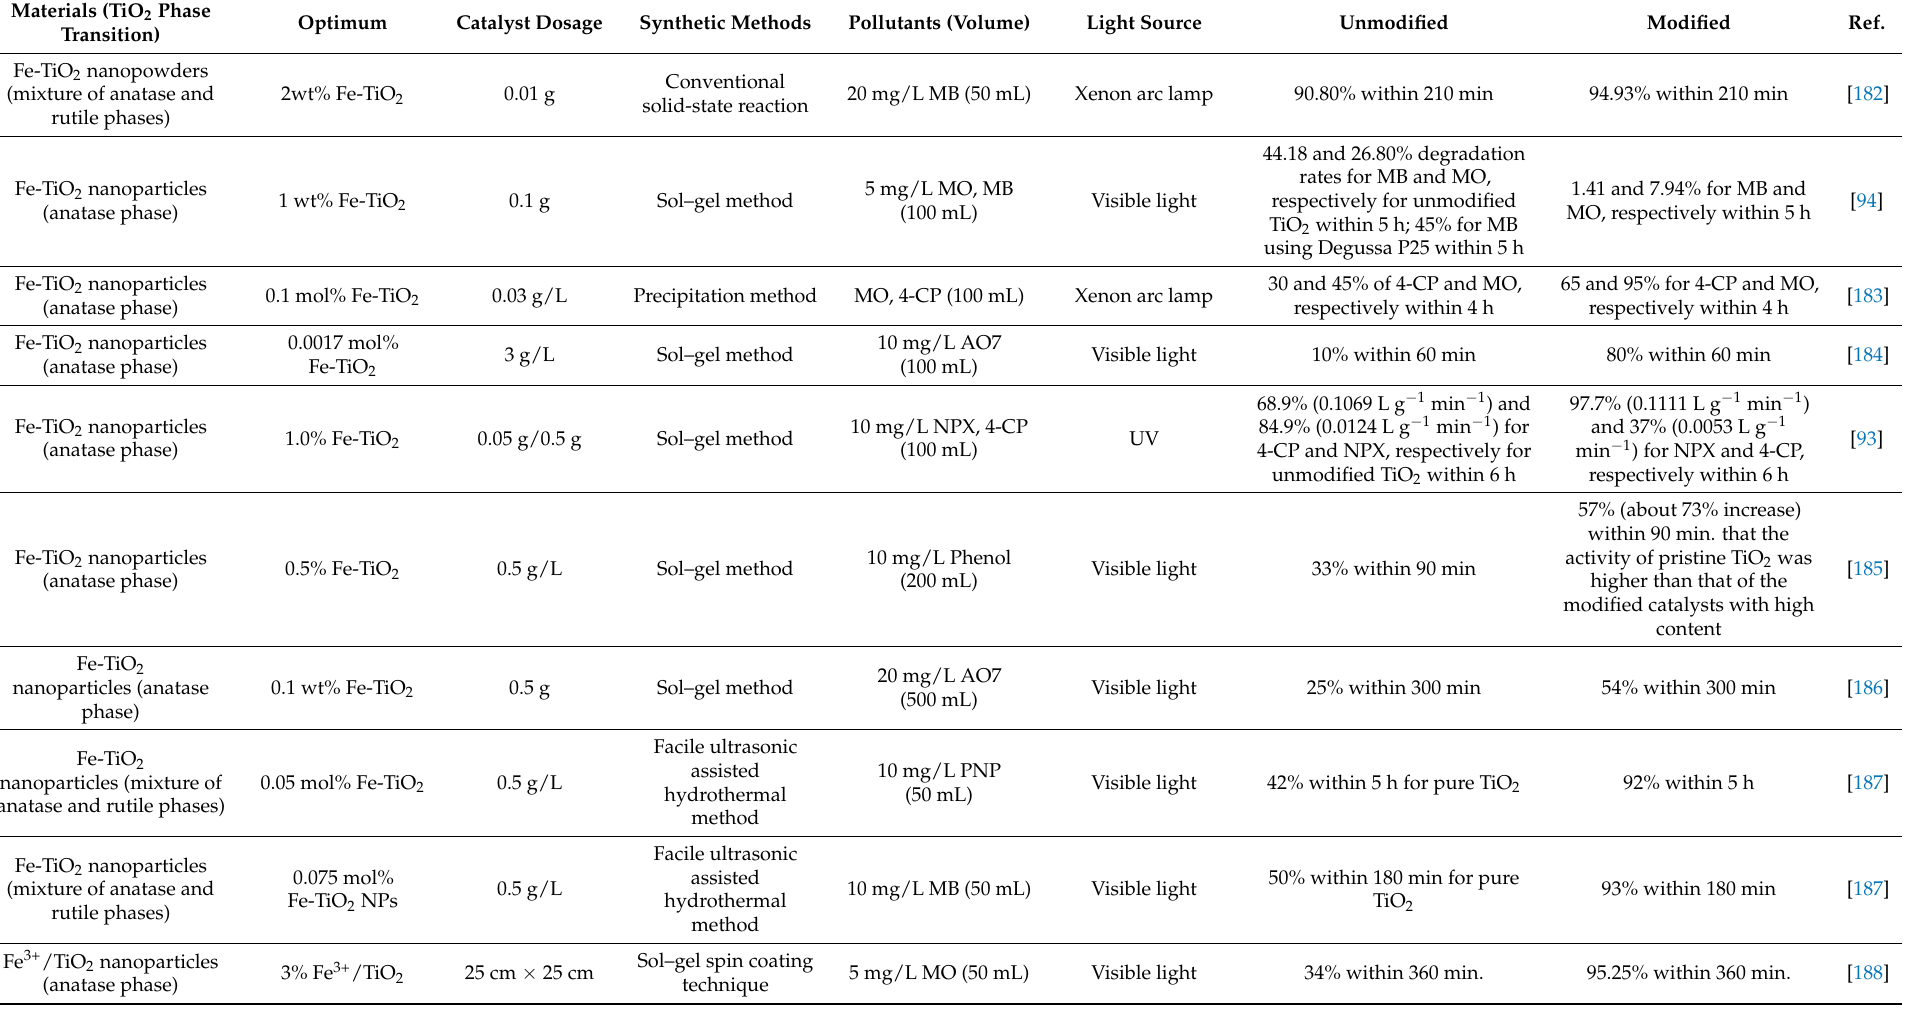
Table 8. Summary of recent progress on Fe-TiO 2 photocatalysts for organic pollutants